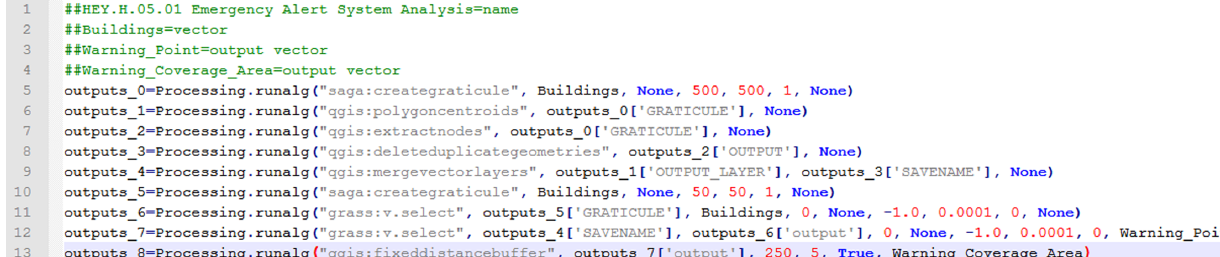
Figure 7. Processing steps of HEY.H.05.01 activity.